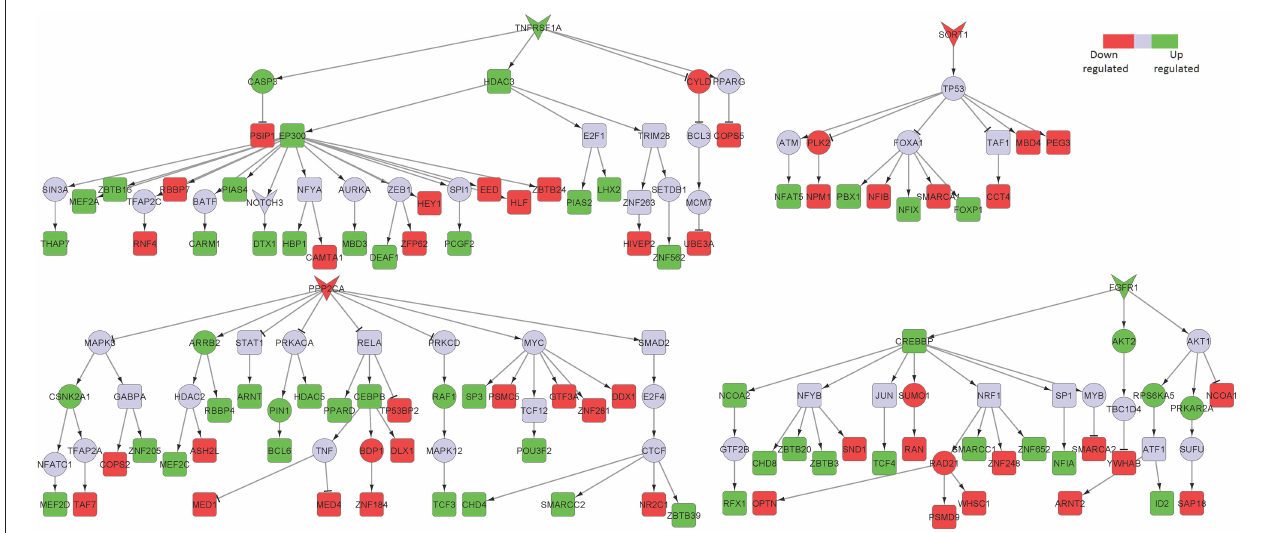
FIGURE 3 | Key signaling networks identified for the posterior cingulate cortex. The figure shows four key signaling subnetworks controlled by TNFRSF1A, FGFR1, SORT1, and PPP2CA identified for posterior cingulate cortex with known role in AD. TNFRSF1A mediated subnetwork consisted of 15 up and 12 down regulated TFs, FGFR1 mediated subnetwork consisted of 8 up- and 6 downregulated TFs, SORT1 mediated subnetwork consisted of 4 up- and 6 downregulated TFs and PPP2CA mediated subnetwork consisted of 15 up- and 13 downregulated TFs. TNFRSF1A and FGFR1 controlled subnetworks represent constantly activated signaling subnetworks while SORT1 and PPP2CA subnetworks represent constantly inhibited ones. The figure legends are the same as that in Figure 2 . Supplementary Figure 2 contains the other subnetworks identified for posterior cingulate cortex that did not have known role in